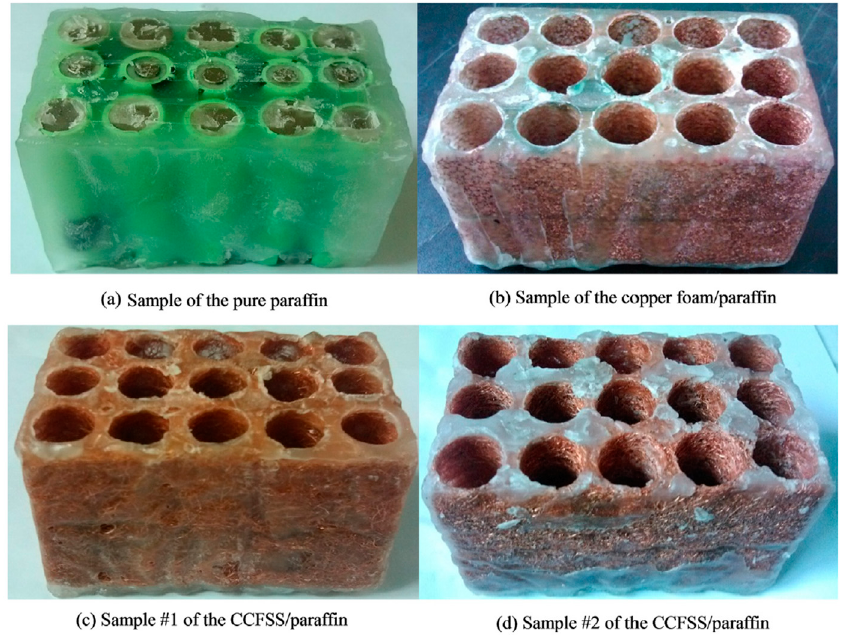
Figure 22. The composite Cu foam—PCM samples discussed in [75]. Reproduced with permission from Elsevier.